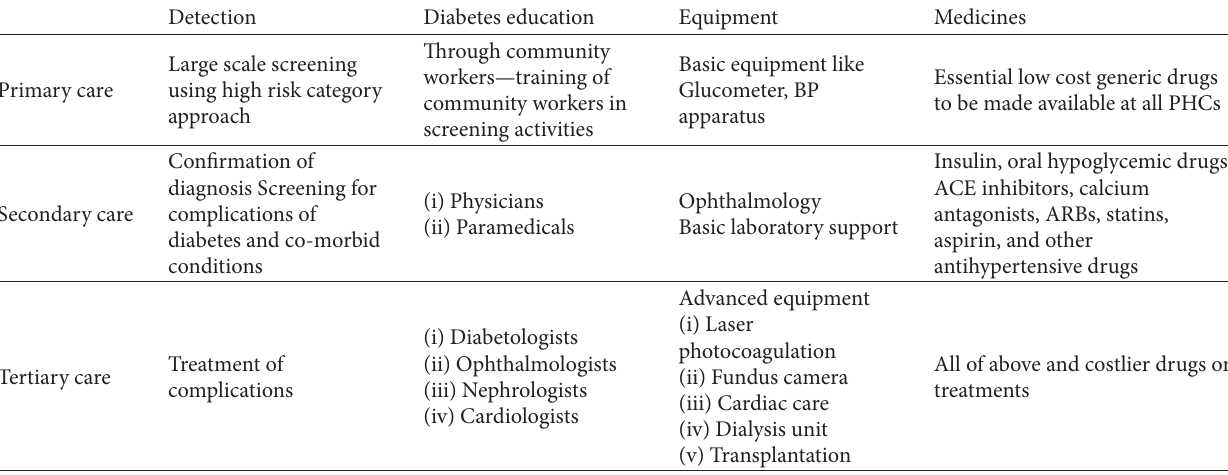
Table 4: Action plans for prevention/control of diabetes and hypertension in different health care